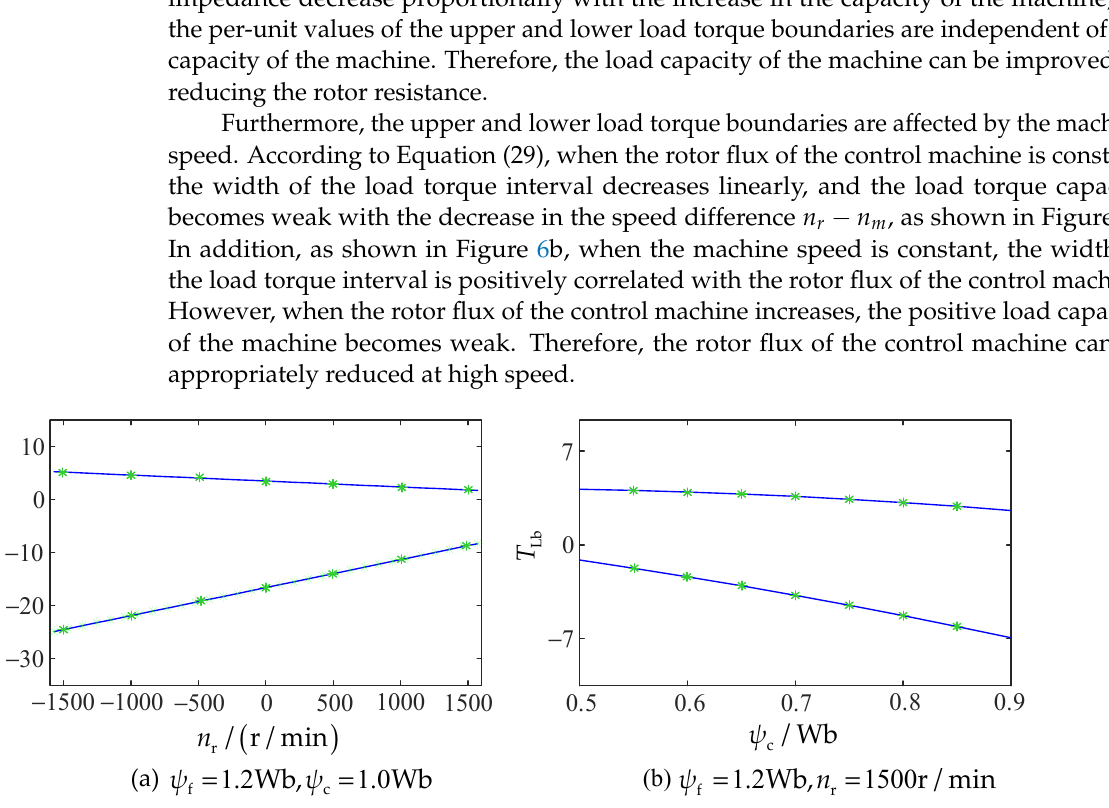
Figure 6. Influence of the speed and rotor flux of the control machine on the upper and lower load torque boundaries. ( a ) Influence of the speed on the upper and lower load torque boundaries; ( b ) influence of the rotor flux of the control machine on the upper and lower load torque boundaries.